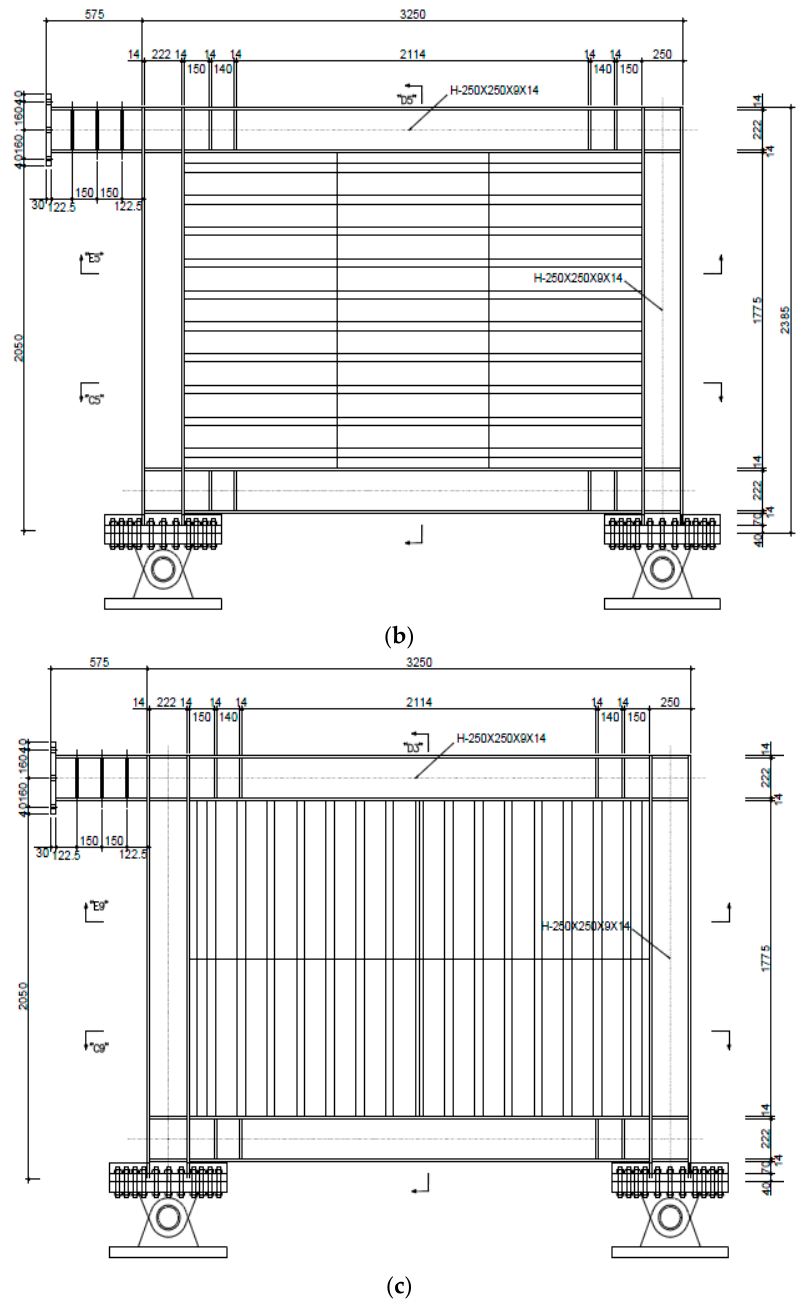
Figure 2. Configuration of the test specimens (unit: mm): ( a ) Simple steel frame: FR-00; ( b ) Steel frame model with a vertical corrugation: FR-TR-V; ( c ) Steel frame model with a horizontal corrugation: FR-TR-H.